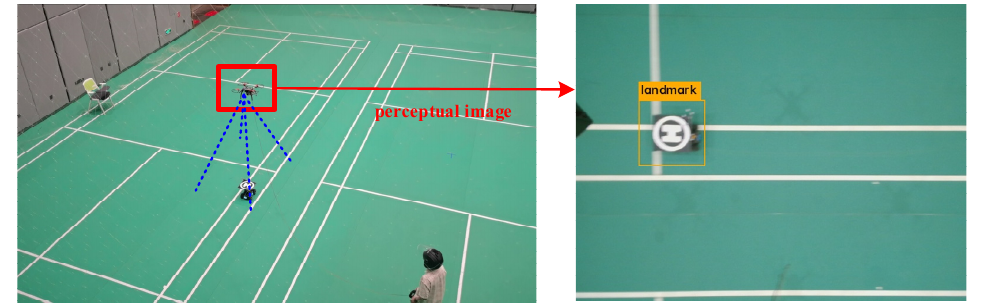
Figure 15. The real-world environment of the flight test.